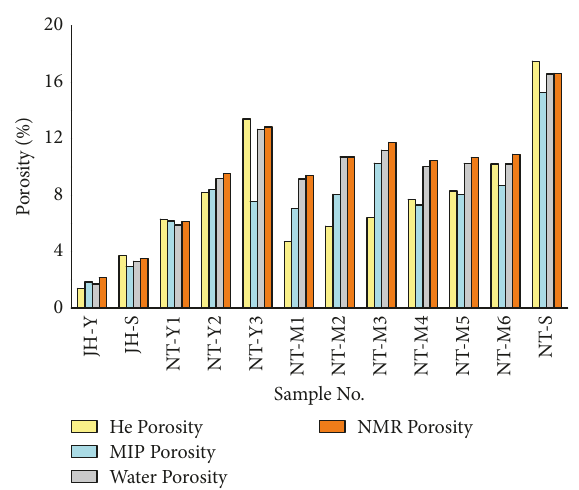
Figure 1: Distributions of the porosities determined by four differ- ent